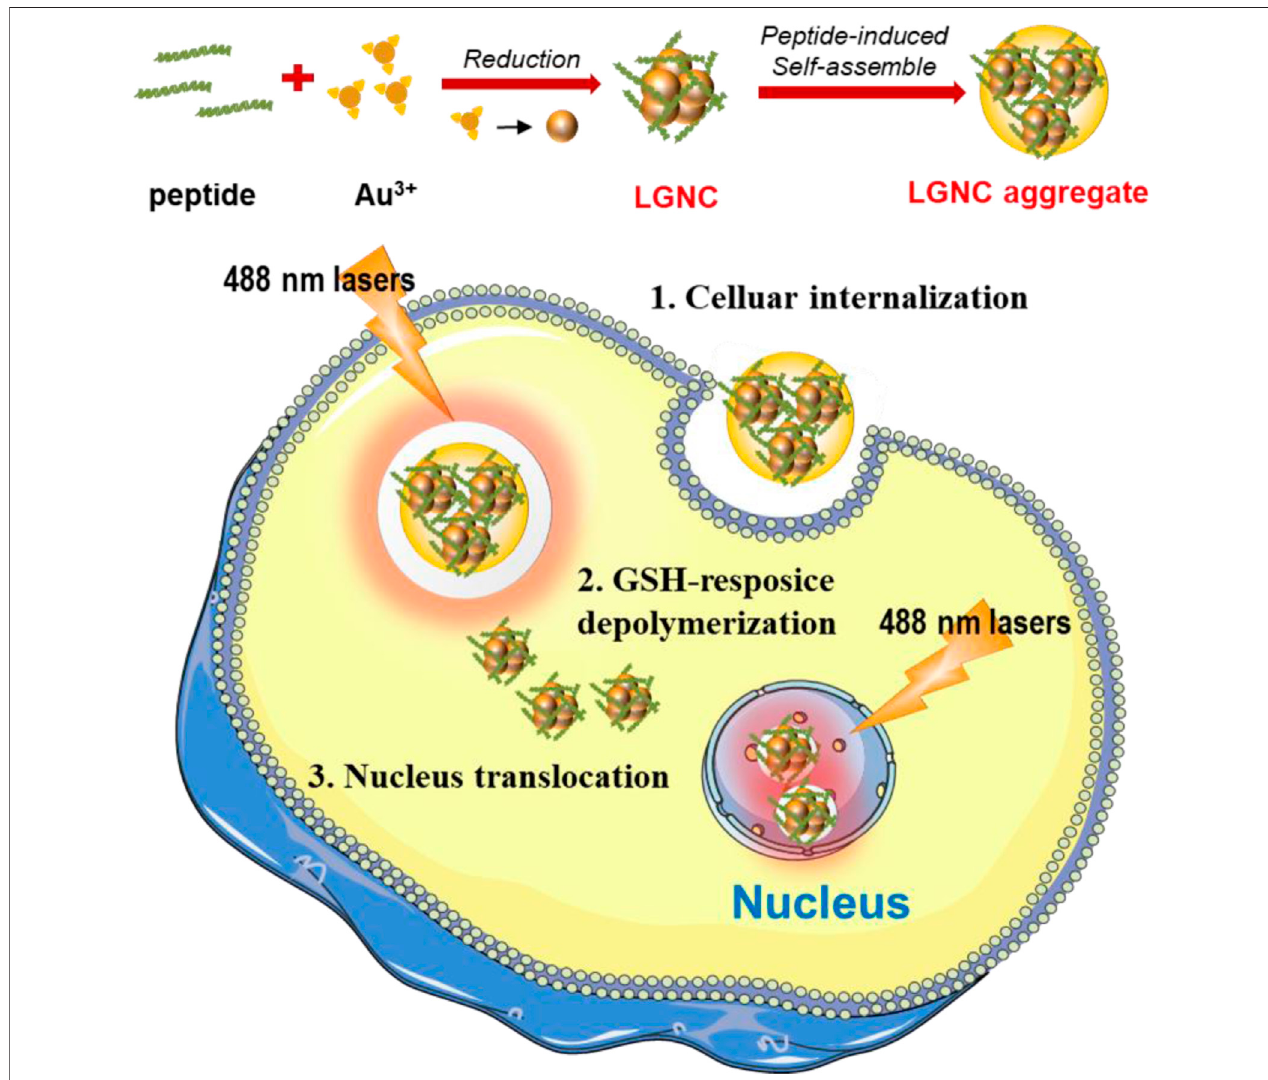
FIGURE 1 | Schematic illustration of lycosin-I-gold nanocluster (GNC) (LGNC) and LGNC aggregate formation and cancer cell nucleus staining after glutathione (GSH)-sensitive depolymerization.